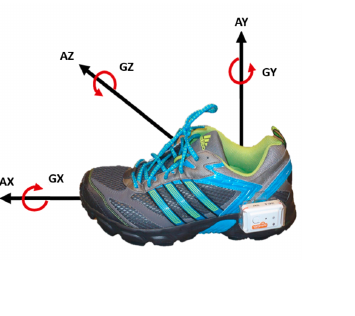
Figure 2. ( Left ) Shimmer sensor placement and axes definition (AX, AY and AZ form three dimensions of accelerometer and GX, GY and GZ form three dimensions of gyroscope); ( Right ) Accelerometer and gyroscope data for one exemplary